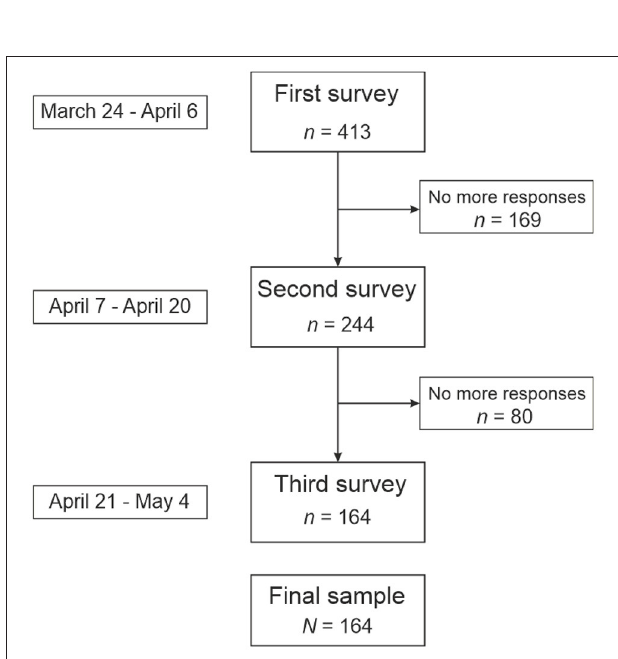
with higher scores representing higher levels of positive affect and lower scores representing lower levels of negative affect for Positive and Negative Affect subscales, respectively. MacDonald’s ω was 0.89 (first survey), 0.94 (second survey), and 0.95